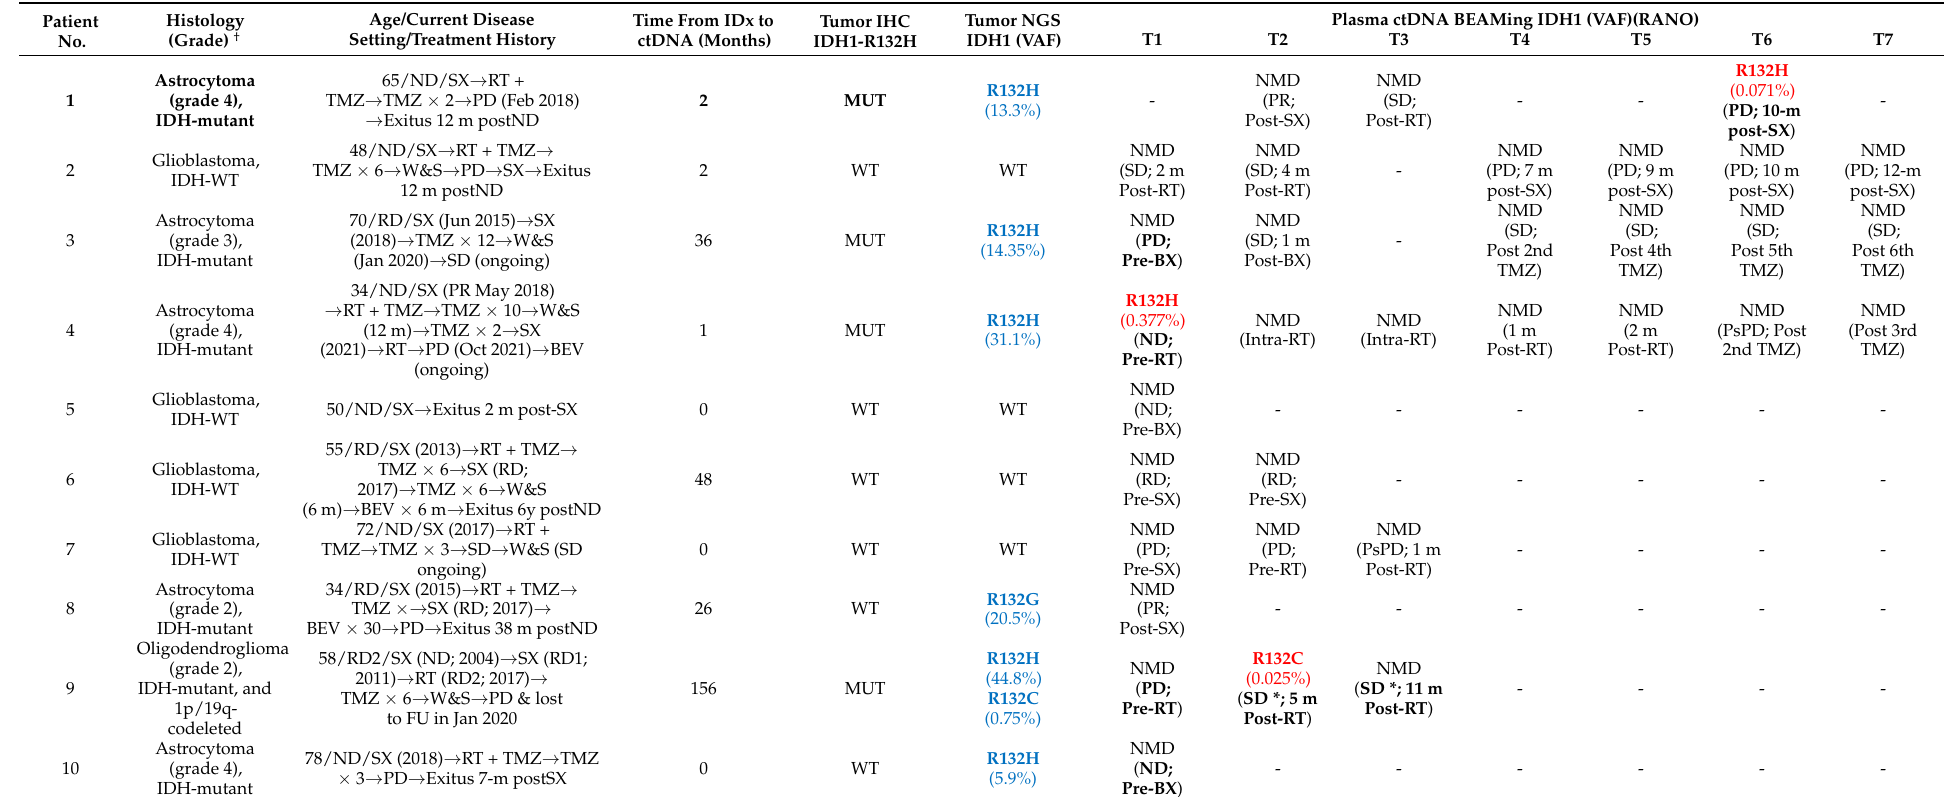
Table 2. Summary of IDH status in tumor and plasma for each